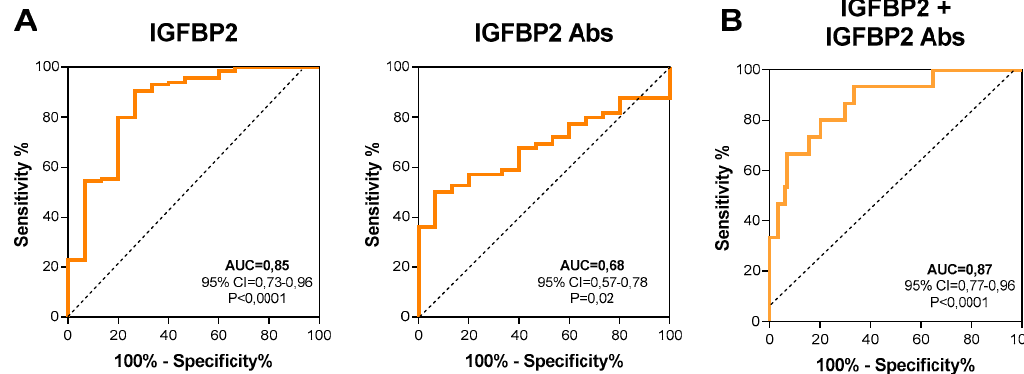
Figure 2. Diagnostic value of IGFBP2 protein and autoantibodies. ( A ) Receiver operating characteristic (ROC) curves of plasmatic IGFBP2 protein and autoantibodies alone or ( B ) in combination, to distinguish RMS patients from healthy subjects. AUC: area under the curve; CI: confidence interval.